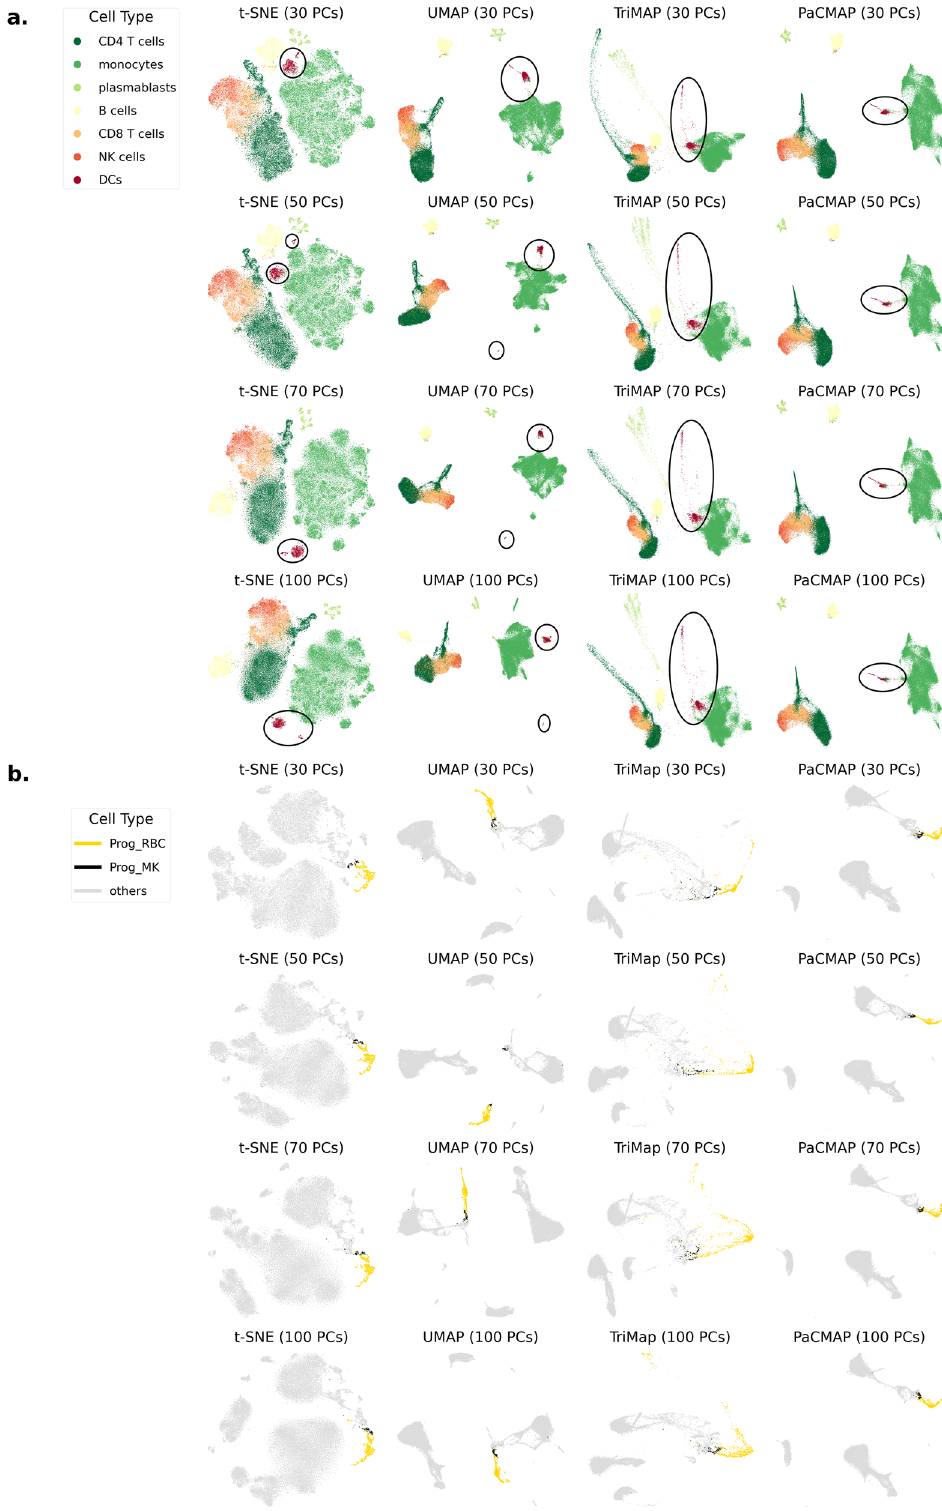
Fig. 6 Sensitivity to the number of PCA dimensions used to initialize DR. a Here we varied the number of PCs on the Kazer et al. 6 dataset. t-SNE and UMAP were not robust to the number of PCs from PCA pre-processing, having different distance relationships between two DCs clusters (pDCs and mDCs), while TriMap and PaCMAP are relatively robust in this respect. b We varied the numbers of input PCs from the Stuart et al. 30 dataset. Here, UMAP is not robust to the number of PCs from PCA pre-processing, generating different results in terms of distance between red blood cell progenitors (Prog_RBC) and megakaryocyte progenitors (Prog_MK) depending on the number of PCs, while t-SNE, TriMap and PaCMAP are rather robust in this aspect. For this dataset, cell types Prog_RBC and Prog_MK should be close to each other, but UMAP with 50 PCs places points belonging to these two cell types far away from each other. Additionally, the Prog_MK cluster is separated into two clusters in UMAP's result with 50